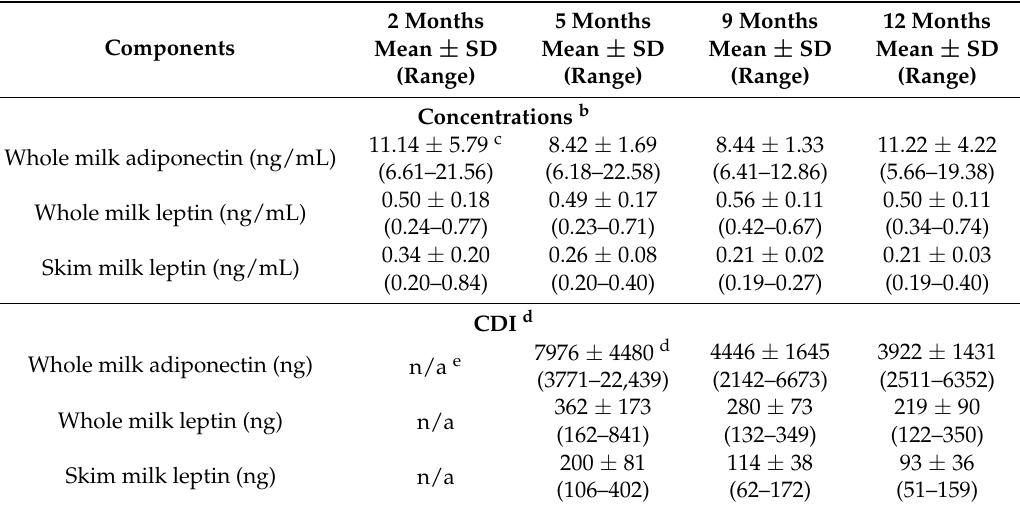
Table 2. Human milk adipokines presented as concentration and 24-h intakes at the months after birth a .